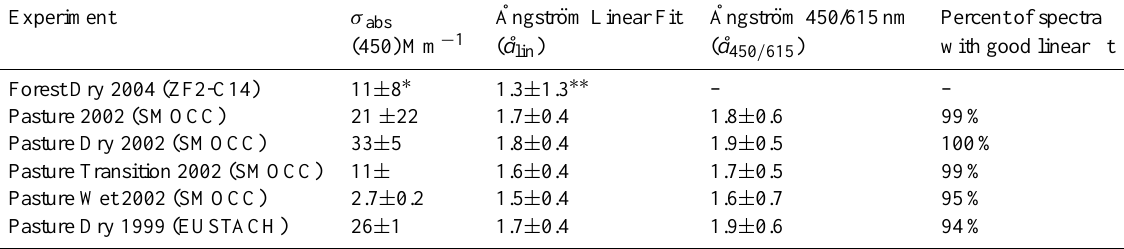
) and between 370 and 880nm ( ˚a 370 / 880 ). Also shown the percentage abs abs ). abs